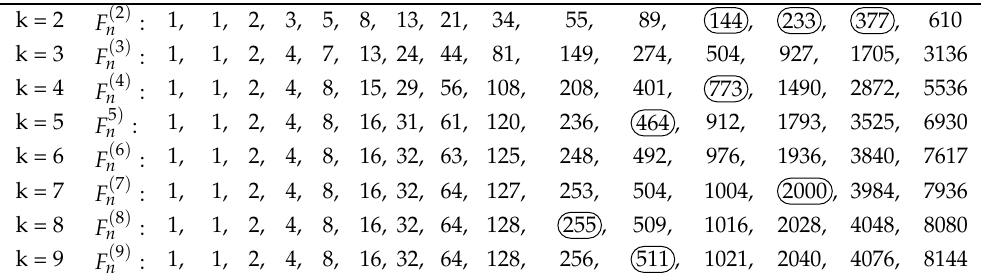
( k ) ≤ k ≤ 9 and 1 ≤ n ≤ 15. The n : for 2